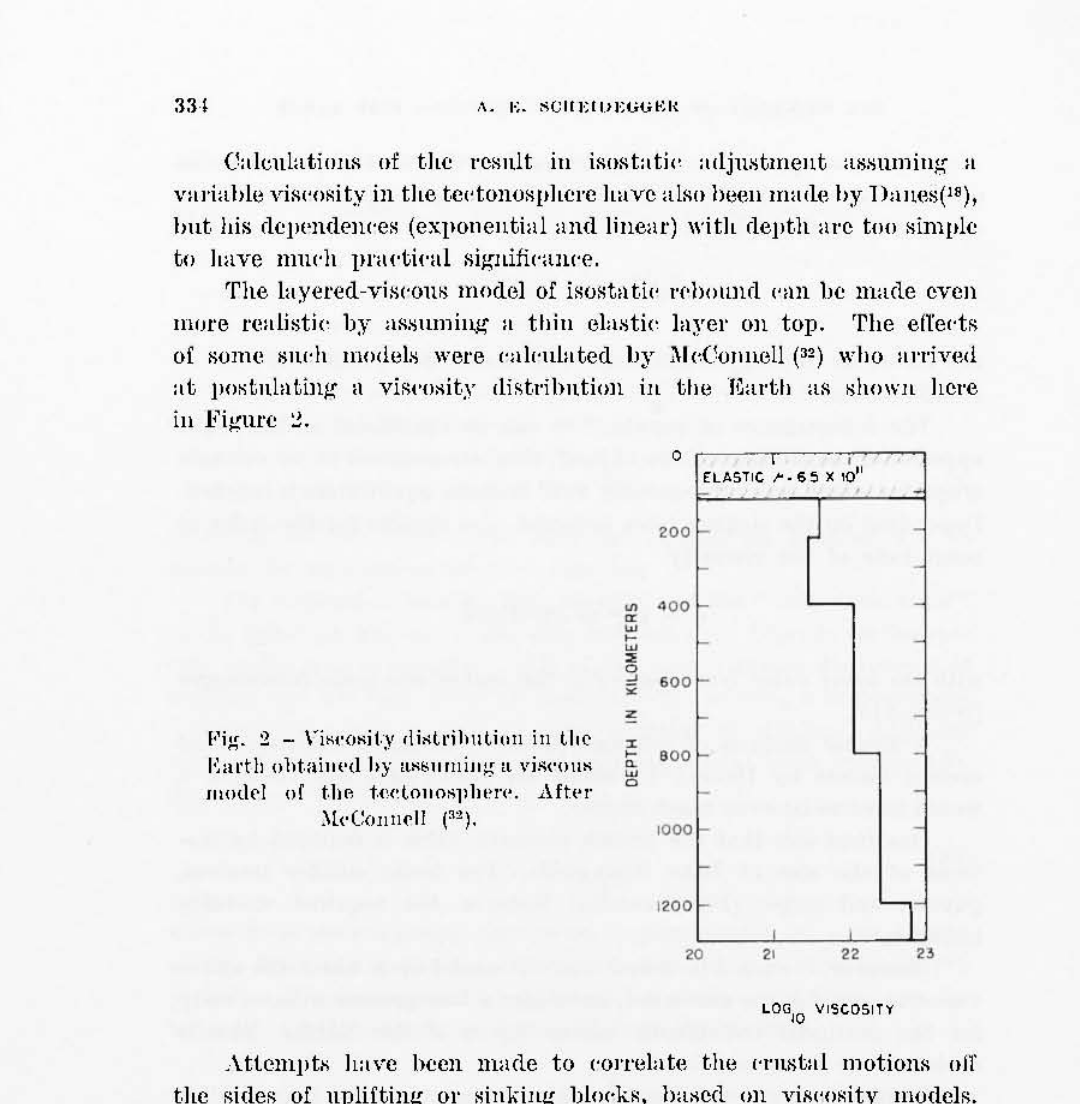
Alternatively, KmliK and UHhakov (2~) eaknlatetl the free snrfaee or a Vili('OUH fluid near a Hllhsitling soli(l material. however, tlUlt f!nl'h l'al(·nlat.ionf! may yield a qualitative agreelllent ellleitlation of the rheolo/"rj('a,l hehavior or the tedonosphere. The (lata ohtainetl rrom an analYHiH or the non-hydrost.atie bnlge or the l~al'th seem tu eGnlirm the viscosity (lif!trihut.ion with depth, obt.aiul\(l